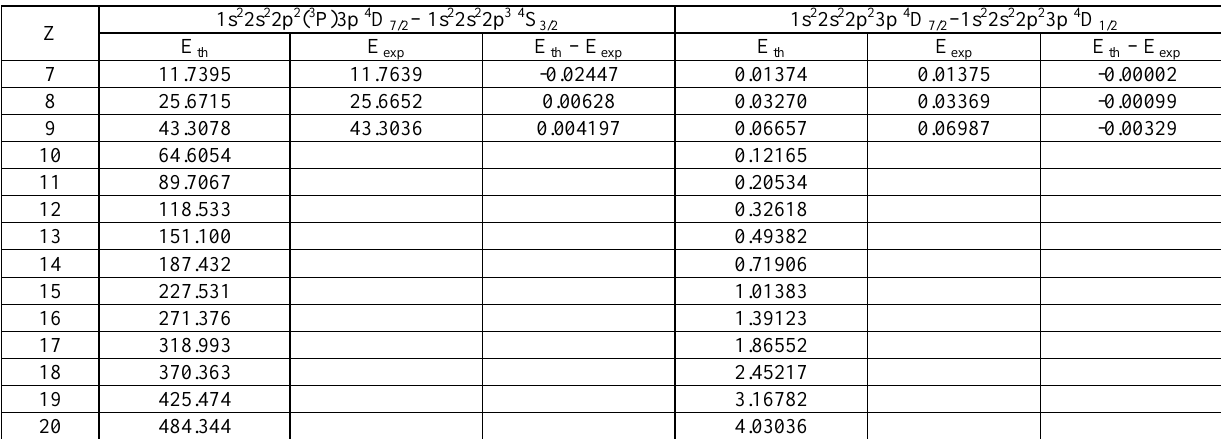
Table 3. Comparison with experiments of the calculated energies (in eV) of 1s 2 2s 2 2p 2 ( 3 P)3p 4 D 7/2 states of nitrogen-like ions and